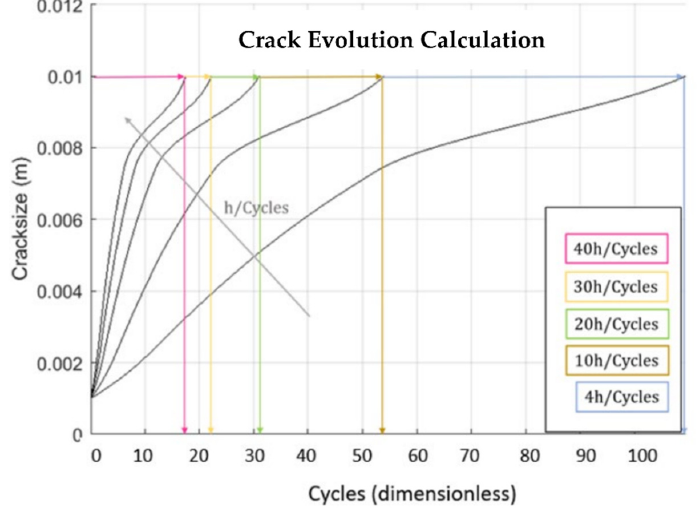
Figure 27. Crack Evolution at the different operating cycles.